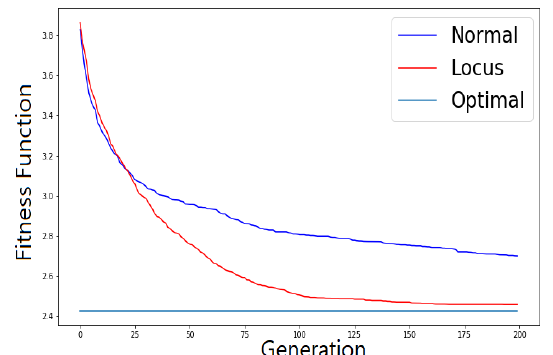
Figure 9. This Figure depicts TSP Problem with 10 cities manifesting the speed and the ability of our approach to nearly reach the optimal solution in comparison with the traditional approach. All the experiments have been conducted with 200 population size, 200 generations and 0.5 mutation rate. The optimal solution has been obtained using brute force algorithm. The experiments were repeated 100